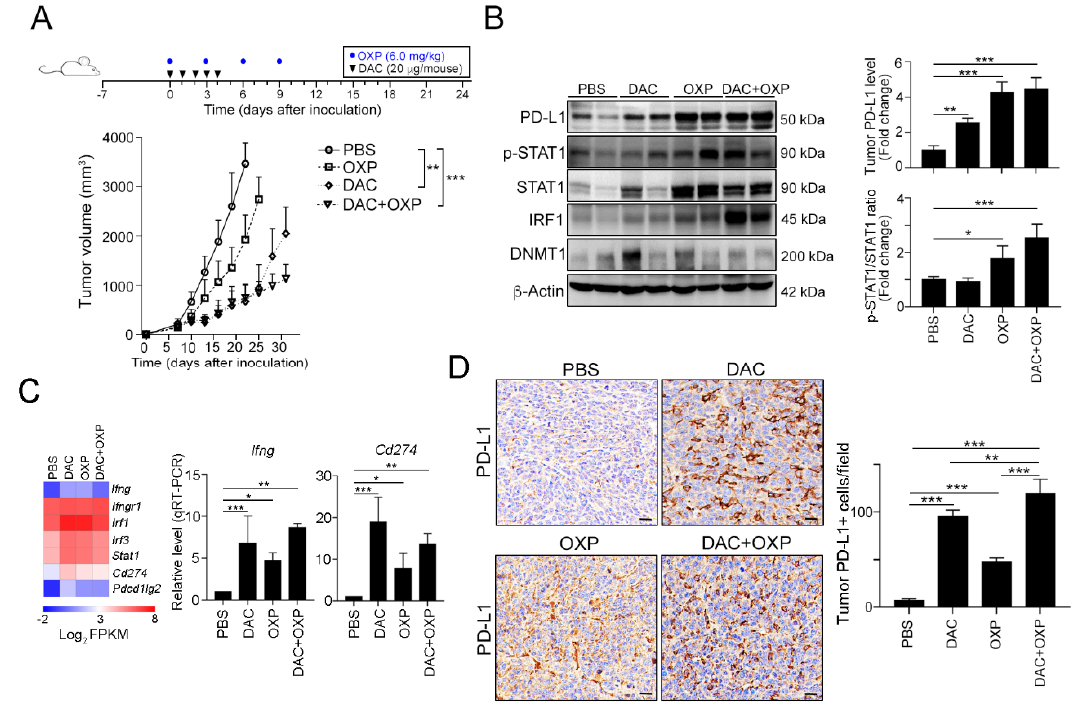
Figure 4. Decitabine synergistically increased the therapeutic response to immunogenic chemotherapy in vivo. ( A ) Tumor-bearing BALB / c mice ( n = 6) were treated with OXP (6 mg / kg, i.p. injection) and decitabine (DAC, 20 µ g / mouse, i.p. injection) at the indicated times shown on the timeline. Tumor volume was measured and calculated every 3 days. The quantification of these results is shown ( n = 6); ** p < 0.01 and *** p < 0.001. ( B ) Resected tumors from representative mice were collected for lysis and then analyzed by immunoblotting. The quantification of these results is shown ( n = 3); * p < 0.05, ** p < 0.01 and *** p < 0.01. ( C ) After treatment with DAC for 5 consecutive days, tumors were resected from representative mice, analyzed by RNA-seq ( n = 2), and validated by qRT-PCR ( n = 3). ( D ) Resected tumors from representative mice were analyzed by immunohistochemistry. Bar: 10 m. The quantification of these results is shown ( n = 4); ** p < 0.01 and